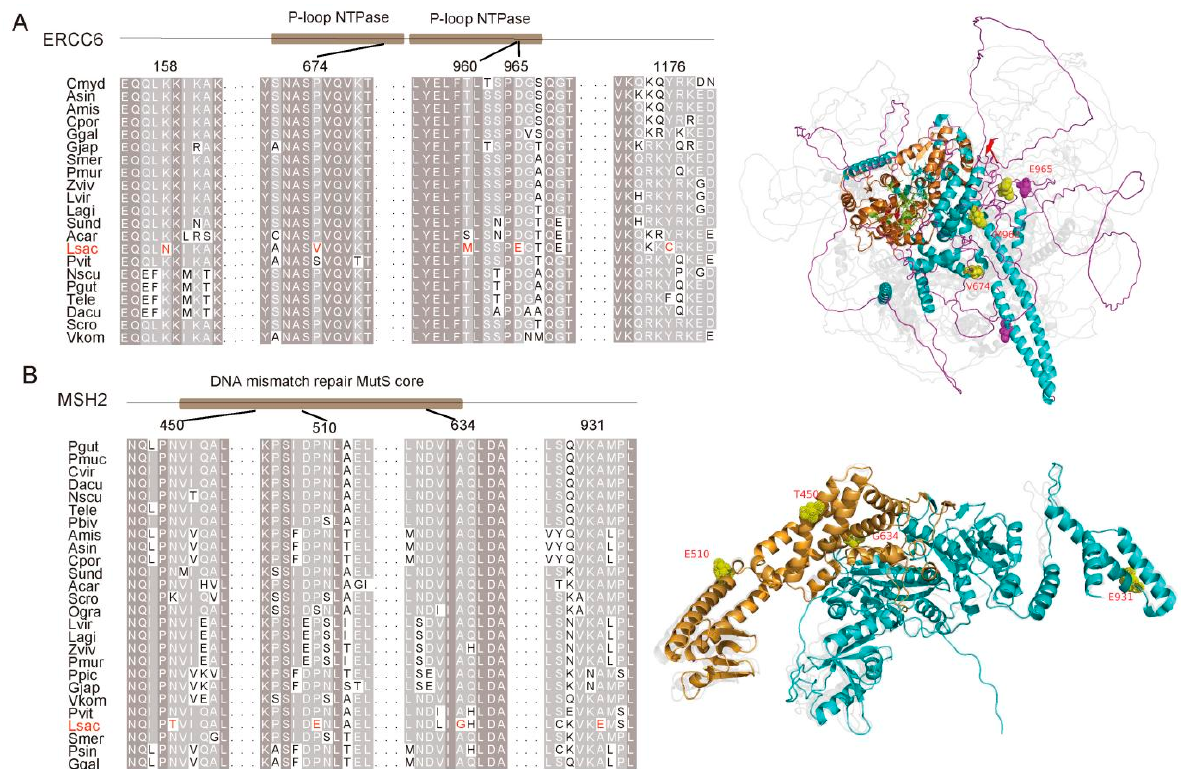
Figure 6. Sequence alignment of ERCC6 and MSH2. ( A ) Sequence alignment showing conserved replacements (red) on L. sacra ERCC6. Positions of mutations on P-loop NTPase domain are indicated. Superimposed protein tertiary structures on the right show mutations on L. sacra ERCC6. ( B ) Sequence alignment showing N450T, P510E, A634G, and A931E mutations on L. sacra MSH2. Mutations in the functional domain are represented by yellow spheres. Full names of the species’ name abbreviations are provided in Table S6.